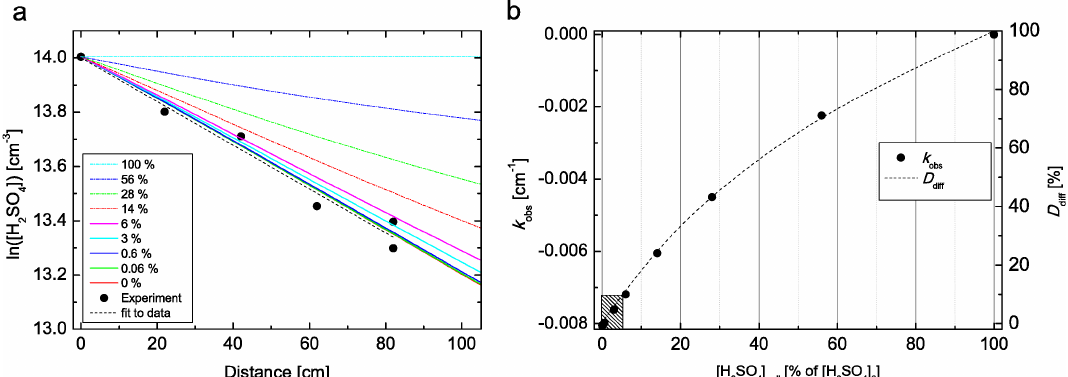
Figure 2. Results from computational fluid dynamics (CFD) FLUENT simulations on the influence of increased H 2 SO 4 concentration on the flow tube wall. ( a ) ln[H 2 SO 4 ] as function of distance in the flow tube. ( b ) k obs and diffusion coefficient difference from the infinite sink boundary condition ( D dif f ) as a function of the H 2 SO 4 concentration on the wall expressed as % of the initial H 2 SO 4 concentration, [H 2 SO 4 ] 0 . The simulations conditions were RH = 5%, T = 298 K and Q tot = 7.6 L · min − 1 . When the H 2 SO 4 concentration on the wall is ≤ 6% of [H 2 SO 4 ] 0 , the resulting difference in the obtained diffusion coefficient is within 10% when compared to diffusion coefficient obtained with infinite sink boundary condition on the wall, as indicated by the shaded box in bottom left corner in Figure 2b. The H 2 SO 4 concentrations are low, ranging from 6.5 × 10 5 to 1.2 × 10 6 molecules · cm − 3 , and the points at each distance are averaged over 20-min with a standard deviation of less than 10% of the average